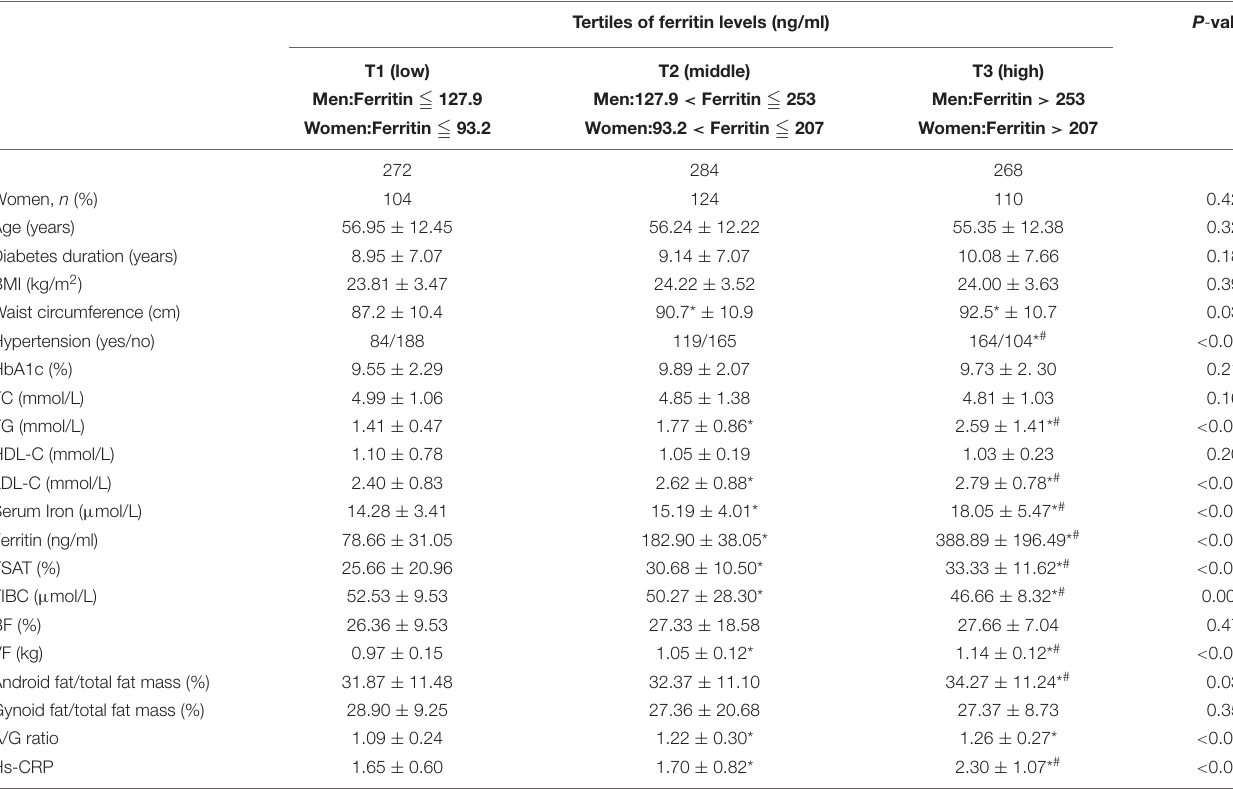
TABLE 1 | Baseline characteristics of study participants according to sex-specific tertiles of ferritin levels. Tertiles of ferritin levels (ng/ml) P -